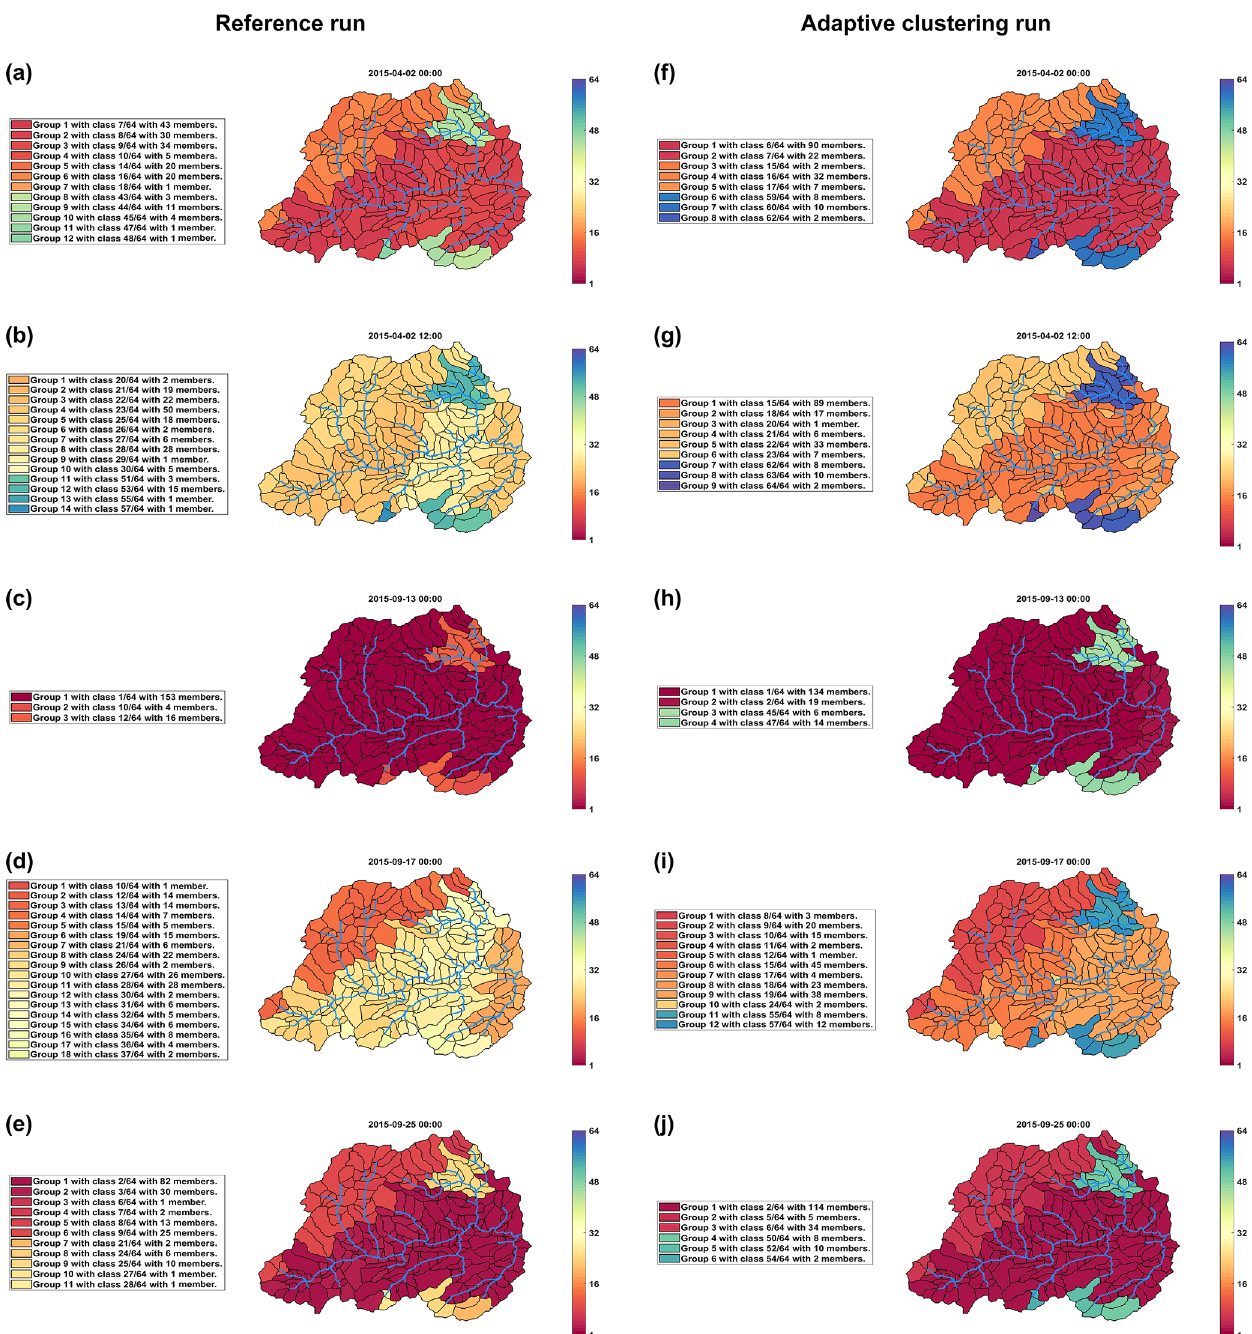
Figure 4. Spatial maps of normalised and binned values of the clustering control variable, q cat , out , for all subcatchments and for selected points in time as marked by the black vertical lines in Fig. 3. Colours indicate the values, which correspond to the bin numbers, ranging from 1 (lowest normalised state – red) to 64 (highest normalised state – blue). Values in (a–e) are from the fully distributed reference run, and values in (f–j) are from an adaptive clustering run with optimised parameters, as shown in Table